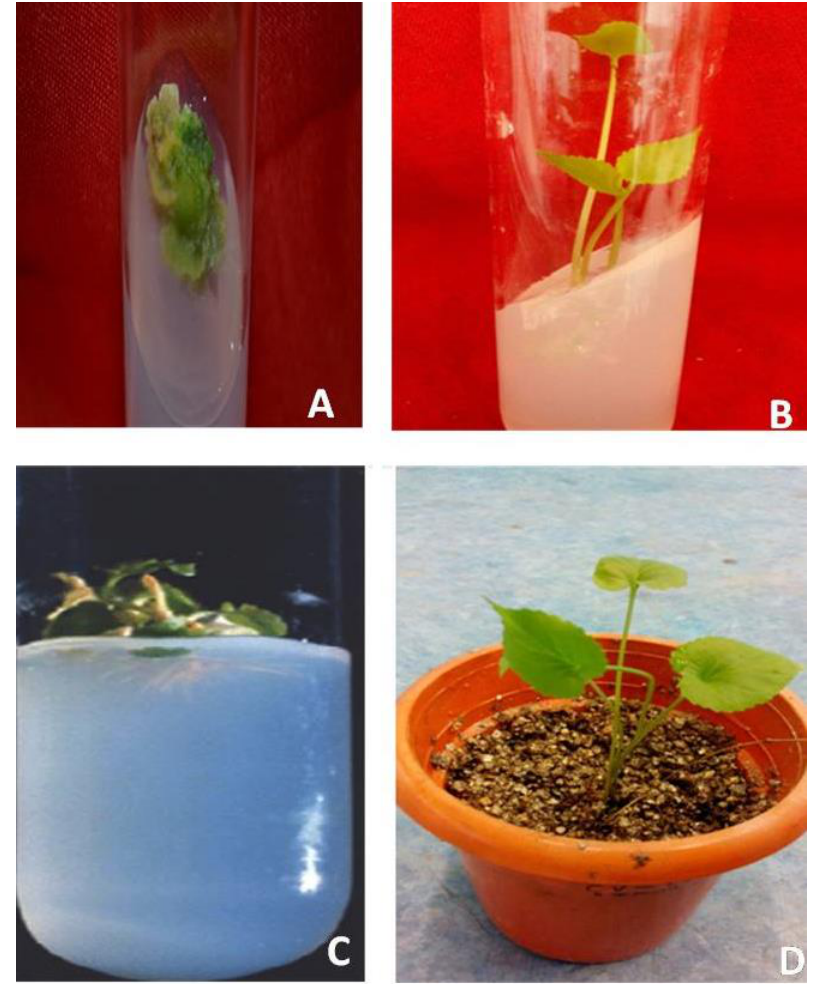
Figure 1. ( A ) Callus induction ( Viola serpens ) on MS medium supplemented with BAP (2.0 mg / L) + 2, 4- D (0.13 mg / L); ( B ) induction of the shoot on MS medium augmented with NAA (0.50 mg / L) + KIN (2.25 mg / L); ( C ) root induction on MS medium with IBA (2.0 mg / L); and ( D ) hardening of